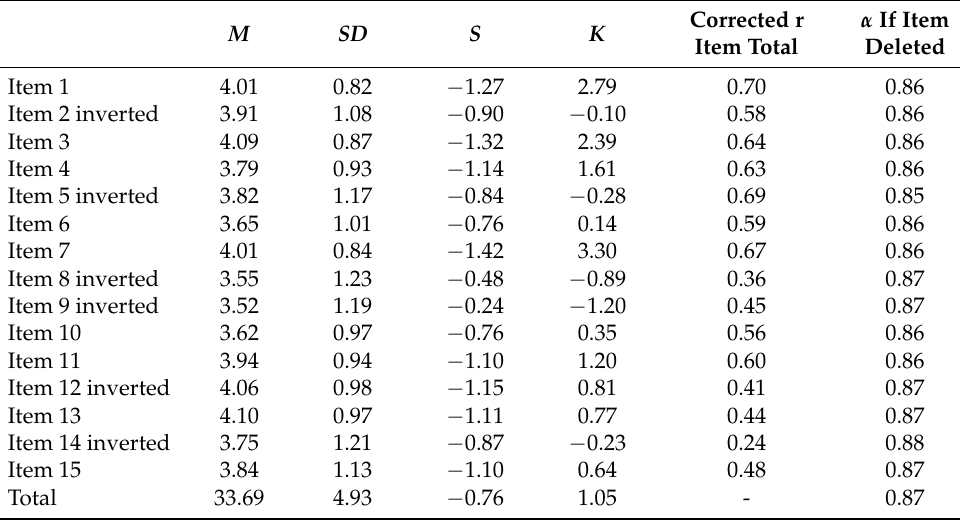
Table 1. Descriptive analysis and discriminant capacities of the original items (N = 205).